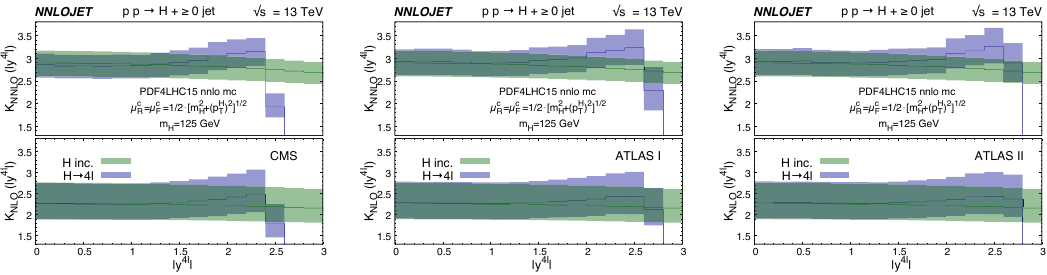
Figure 5. Rapidity distributions of the inclusive Higgs boson or four-lepton system from Higgs boson decay for CMS (left), ATLAS I (centre) and ATLAS II (right) cuts and normalised by the corresponding LO